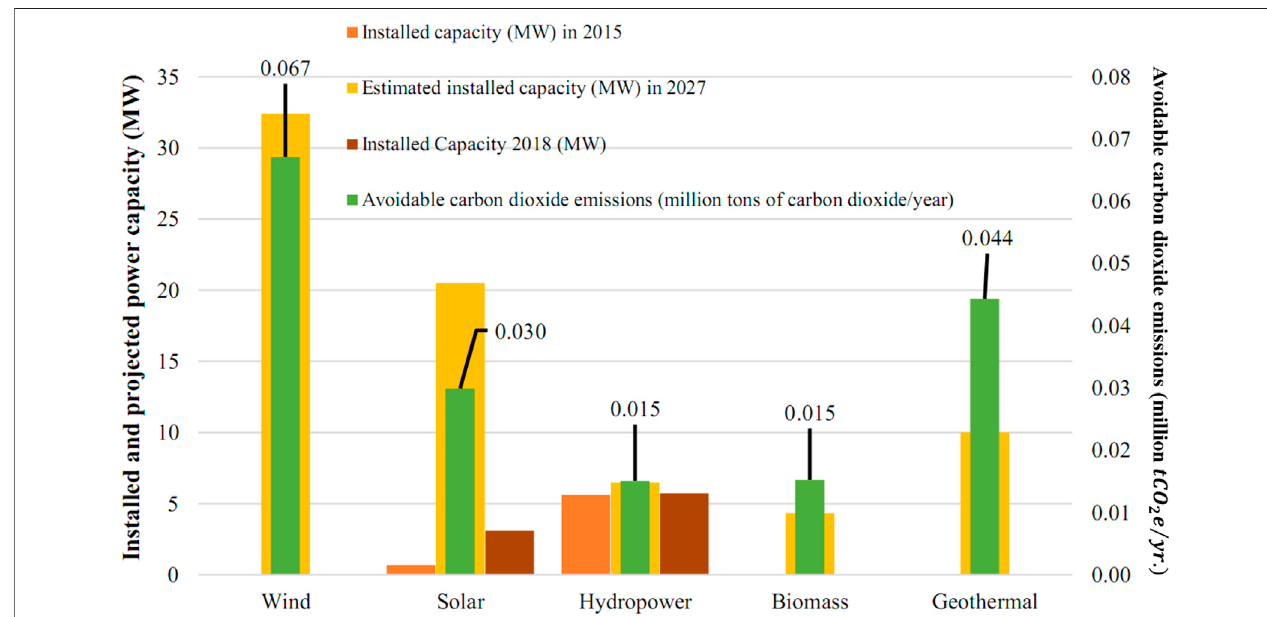
TABLE 2 | Table identifying the updated data for the SVG01, SVG02 and SVG03 drilled to date, duration, fl uid temperature, depths the wells have collapsed and the estimated conversion ef fi